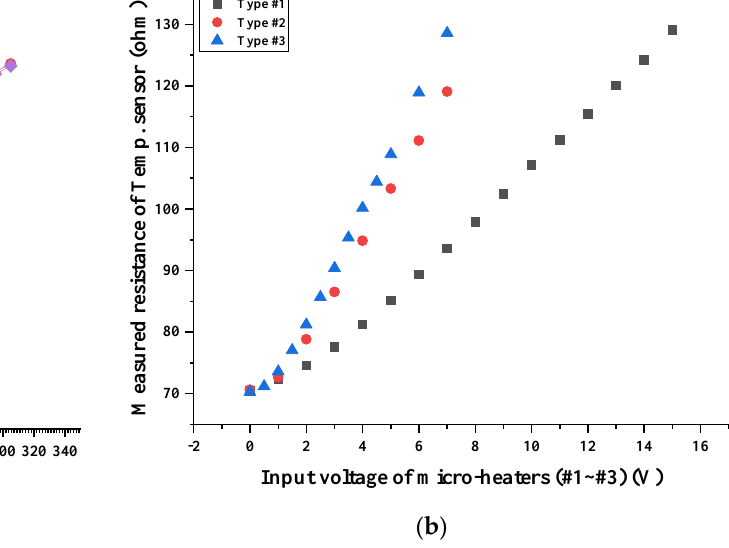
Figure 6. Graphs of ( a ) measured resistance of temperature sensor as a function of temperature change and ( b ) measured resistance of temperature as a function of micro-heater input voltage. To characterize the fabricated SnO 2 -based H 2 S microsensor with micro-heaters (types #1 – #3), it was placed in the prepared gas chamber and H 2 S gas was injected at a concentration of 0 to 10 ppm. The operating temperature of the H 2 S microsensor can be estimated via the measured resistance of the temperature sensor, along with the input voltage ap- plied to micro-heaters. Table 1 presents the expected operating temperature and power consumption along with the input voltage applied to